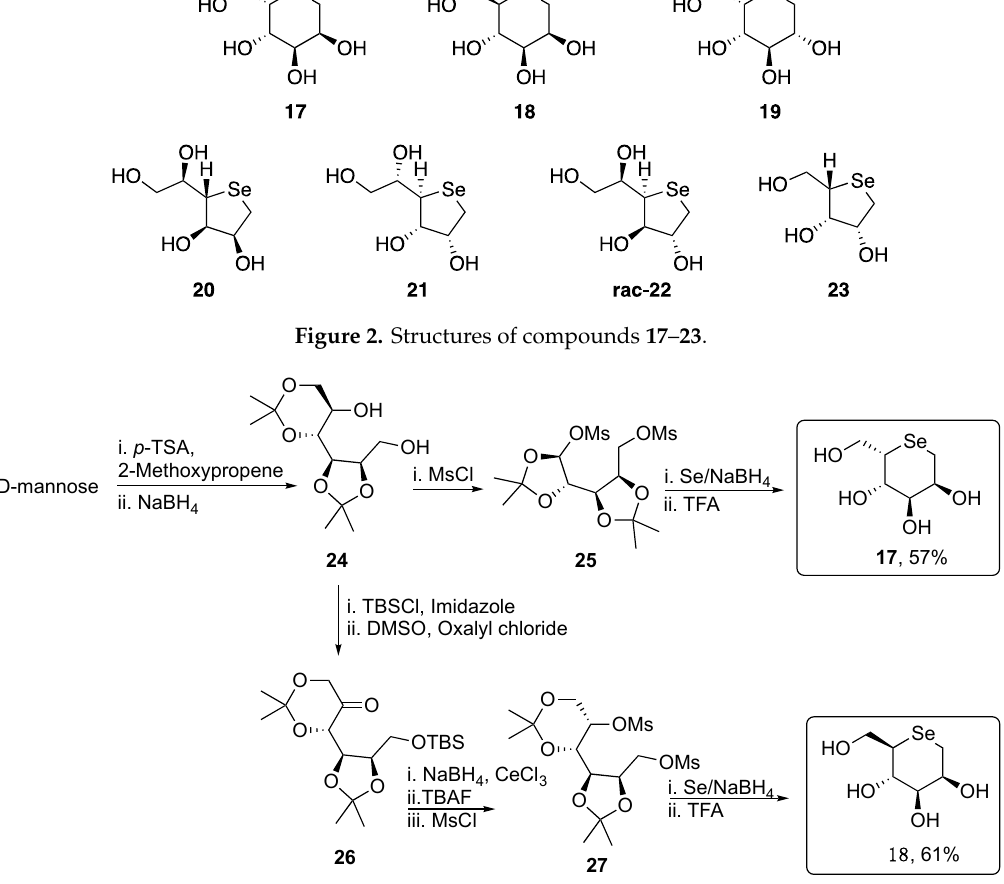
Figure 2. Structures of compounds 17 – 23 .